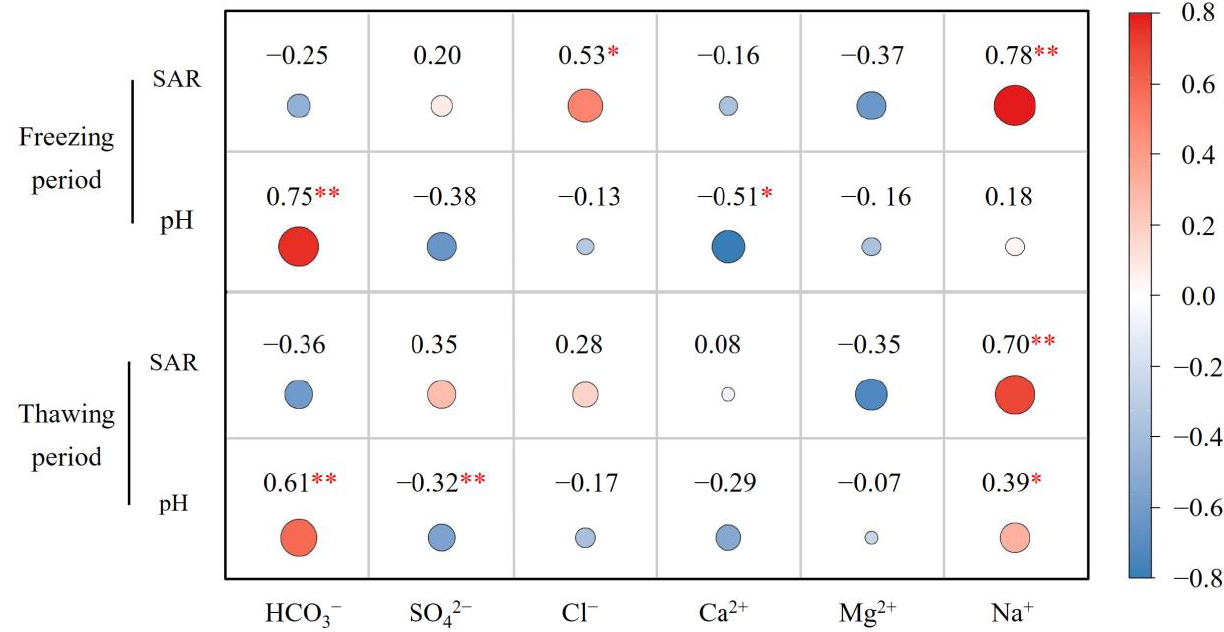
Figure 9. Correlation coefficient matrix of soil soluble ions and soil pH, SAR. Red denotes a positive correlation and blue denotes a negative correlation. **, p < 0.01; *, p < 0.05.